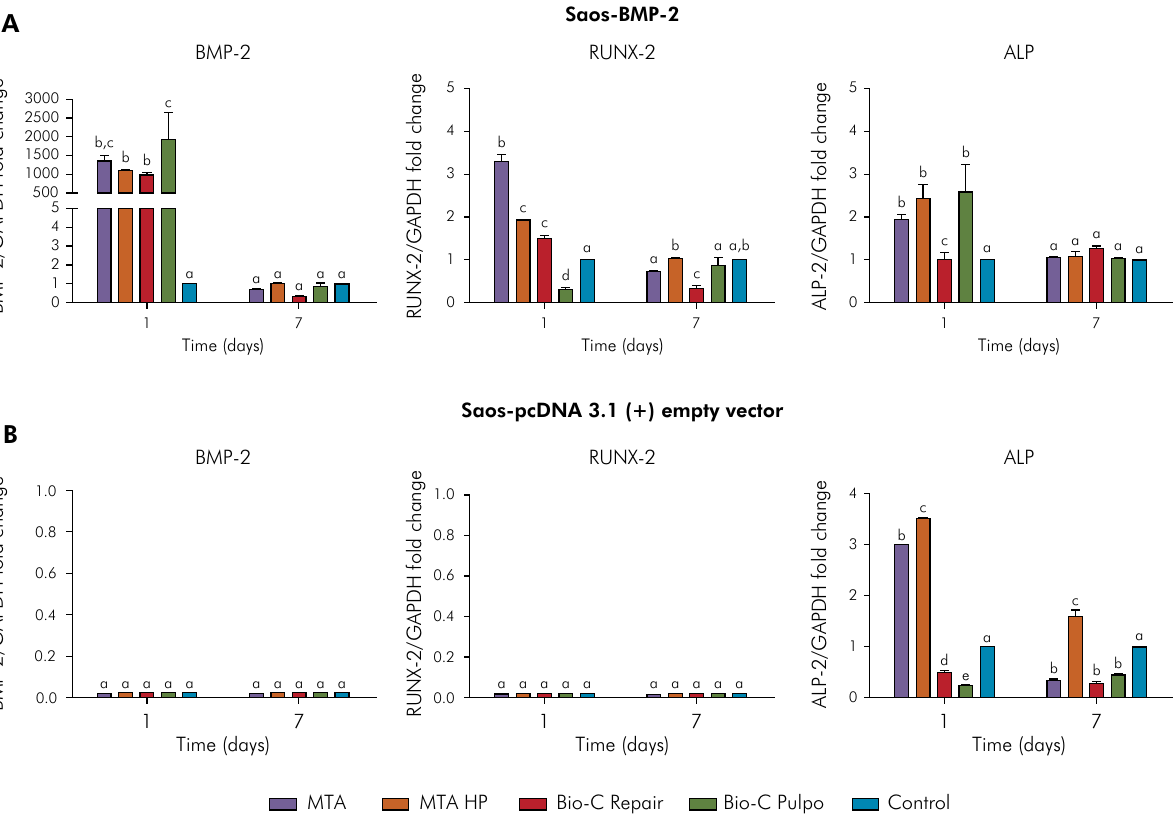
Figure 5. mRNA expression levels of target genes in (a) Saos-BMP-2 transfected cells and (b) Saos-pcDNA 3.1 (+) empty vector exposed to MTA, MTA HP, Bio-C Repair, Bio-C Pulpo at 1:12 dilution and to culture medium (control) for 1 and 7 days. Identical triplicates were prepared for each reaction, and the experiment was repeated three times independently (n = 3/group). Bars with different letters represent significant differences among the